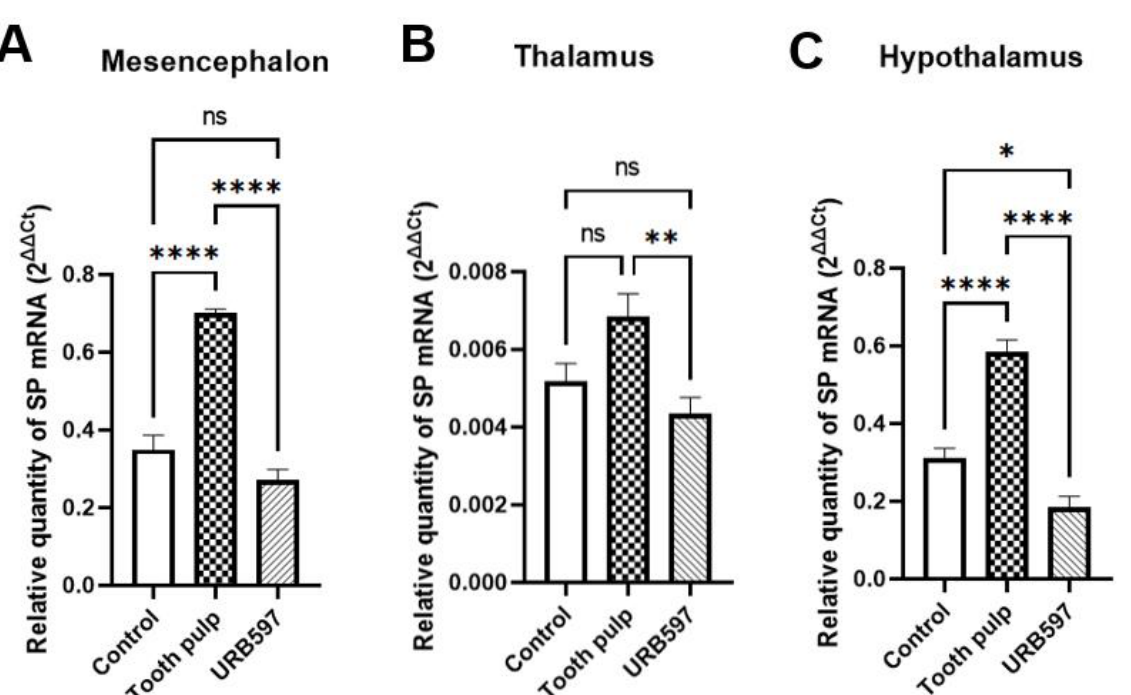
Figure 2. Quantitative RT-PCR analysis of SP mRNA expression in ( A ) mesencephalon, ( B ) thalamus and ( C ) hypothalamus induced by tooth pulp and URB597 treatment. The data represent mean ± SEM of 6 rats per group. Statistical significance was assessed using one-way ANOVA and a post hoc multiple comparison Tukey test. Asterisks denote significance level (* p < 0.05, ** p < 0.01, **** p < 0.0001, ns — not statistically significant).